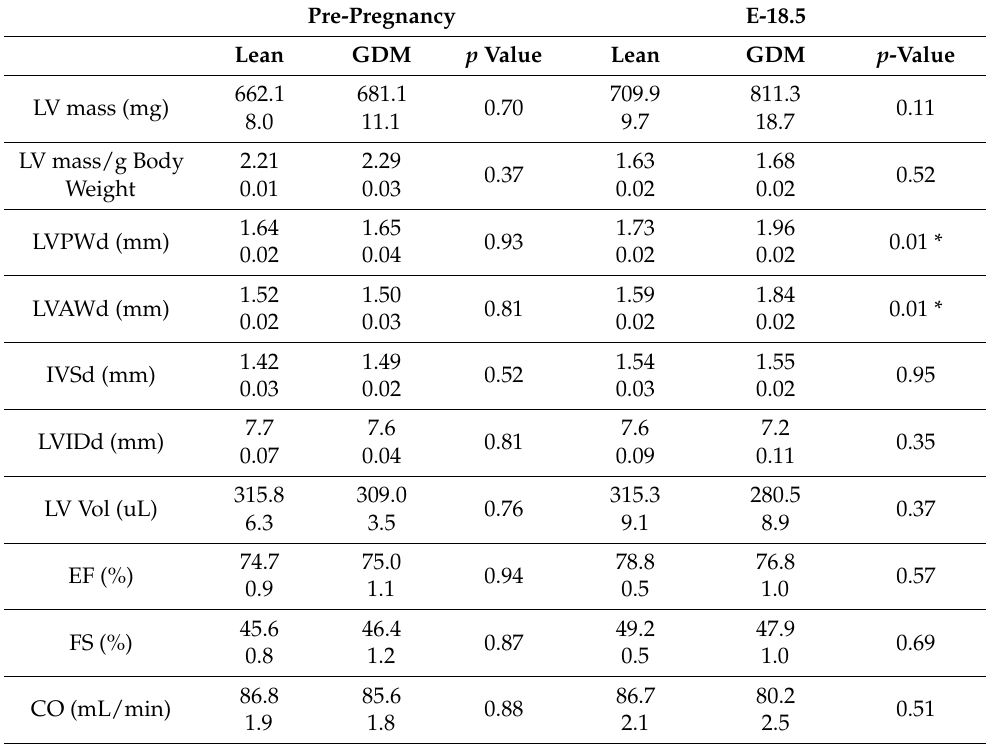
Table 1. Echocardiography parameters in female